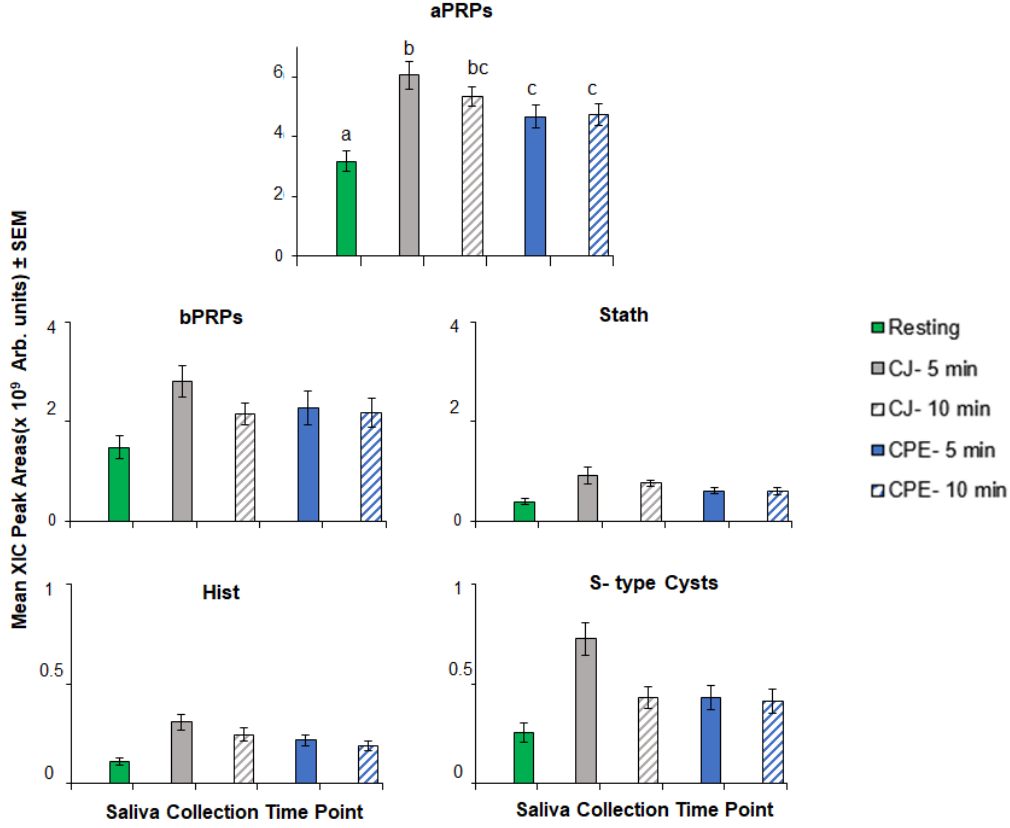
Figure 2. Extracted ion current (XIC) peak areas (mean values × 10 9 ± SEM) in arbitrary units for salivary protein families following stimulation with cranberry juice (CJ) and cranberry-derived polyphenol extract (CPE) ( n = 60). Values with di ff erent superscript letters (a, b etc.) di ff er at p < 0.05. Interaction e ff ects: There was no overall e ff ect of stimulation on bPRP levels (with either CJ or CPE). However, there was a significant gender*taster*treatment e ff ect ( F [4,224] = 2.60, p = 0.037) on bPRPs (Figure